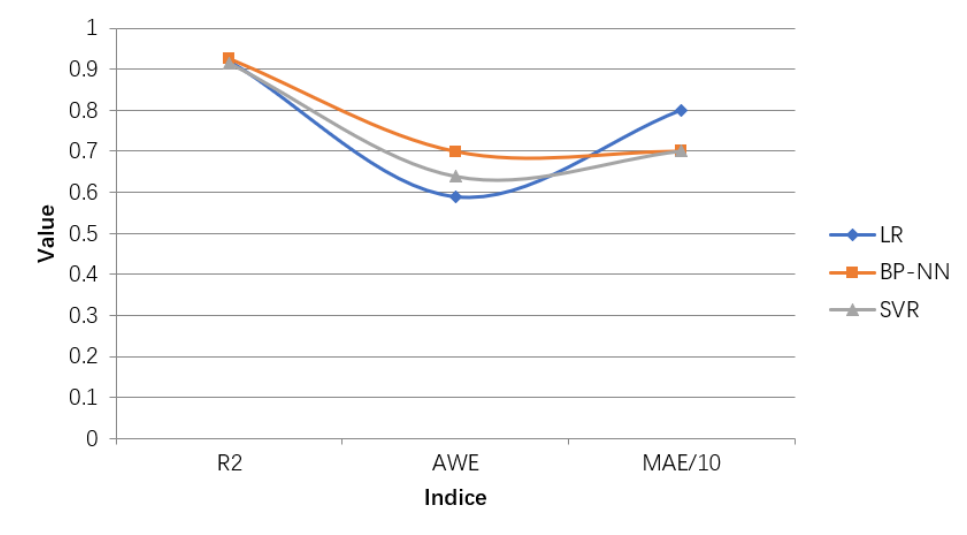
Figure 12. Line chart comparing the training results of different machine learning regression algorithms. The value represents results for R2, MAE/10, AWE for different parameters settings.